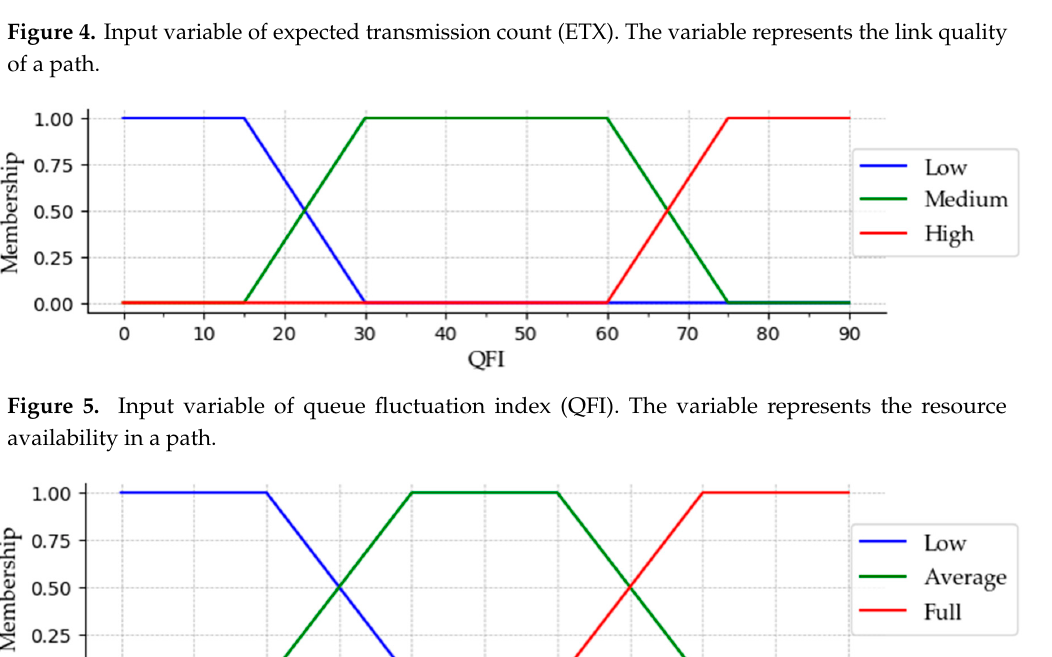
Figure 4. Input variable of expected transmission count (ETX). The variable represents the link quality of a path.